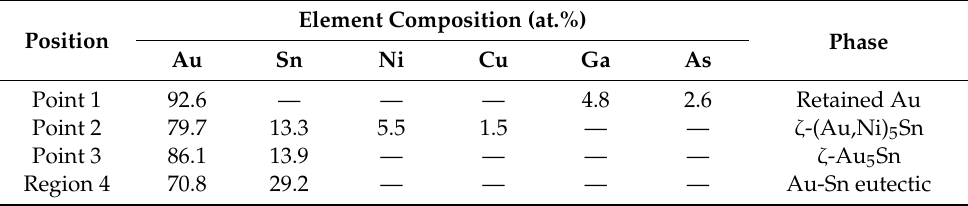
Figure 4. Au-Sn phase diagram [22]. The elemental distribution across the TiW/Au|Au-Sn eutectic joint was analyzed using EDS ( OXFORD, Oxford, UK). The measured position and results are shown in Figure 5. The distribution of Au from the brazed region to the back Au layer of MMIC increased gradually, while the distribution of Sn presented a steep decrease. A metallurgical combination of the brazed region to MMIC was mainly achieved through the partial dissolution of the back Au layer in the melting Au-Sn solder. A transition zone from the brazed region to the Ni metallization layer of the Mo/Cu alloy was evident, displaying a noticeable increase in Ni and a decrease in Au. According to the microstructure, the transition zone consisted of ζ -(Au,Ni) 5 Sn IMC. Since the peak heating temperature was maintained for less than 30 s, the ζ -(Au,Ni) 5 Sn interface was only 1.5 µm thick. Joining of the brazed region to Mo/Cu alloy was realized by the diffusion between the Ni metallization layer and the Au-Sn solder. The Au metallization layer prevented the oxidation of the Ni layer before soldering. A noticeable peak of Sn appeared in the center of the brazed region, while a valley was evident at each side of the brazed region. Therefore, Au-enriched ζ -Au 5 Sn was initially formed during the solidification process, whereas Sn was segregated in the residual liquid.